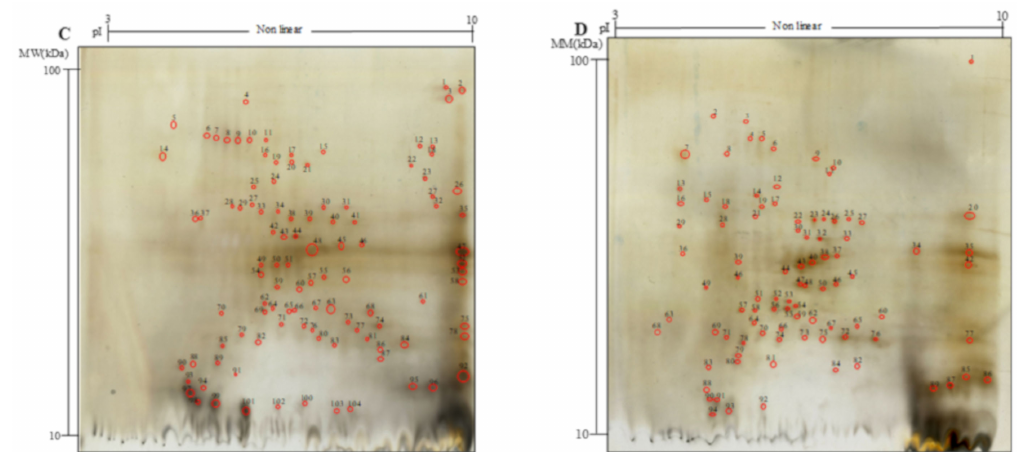
Figure 1. Two-dimensional gel electrophoresis (2-DE) analysis of the water / salt soluble proteins of raw and bioprocessed hemp. Panel ( A ), untreated hemp dough (H); ( B ), hemp dough treated with xylanase Depol 761P (1% wt / wt of fiber) (H X ); ( C ), hemp dough treated with protease VeronPS (2.5% wt / wt of protein) (H P ); ( D ), hemp dough fermented by Lactiplantibacillus plantarum 18S9 and Leuconostoc mesenteroides 12MM1 (ratio 1:1, final cell density of circa 7 log10 cfu / g) (H F ). All treated samples were incubated at 30 ◦ C for 24 h.